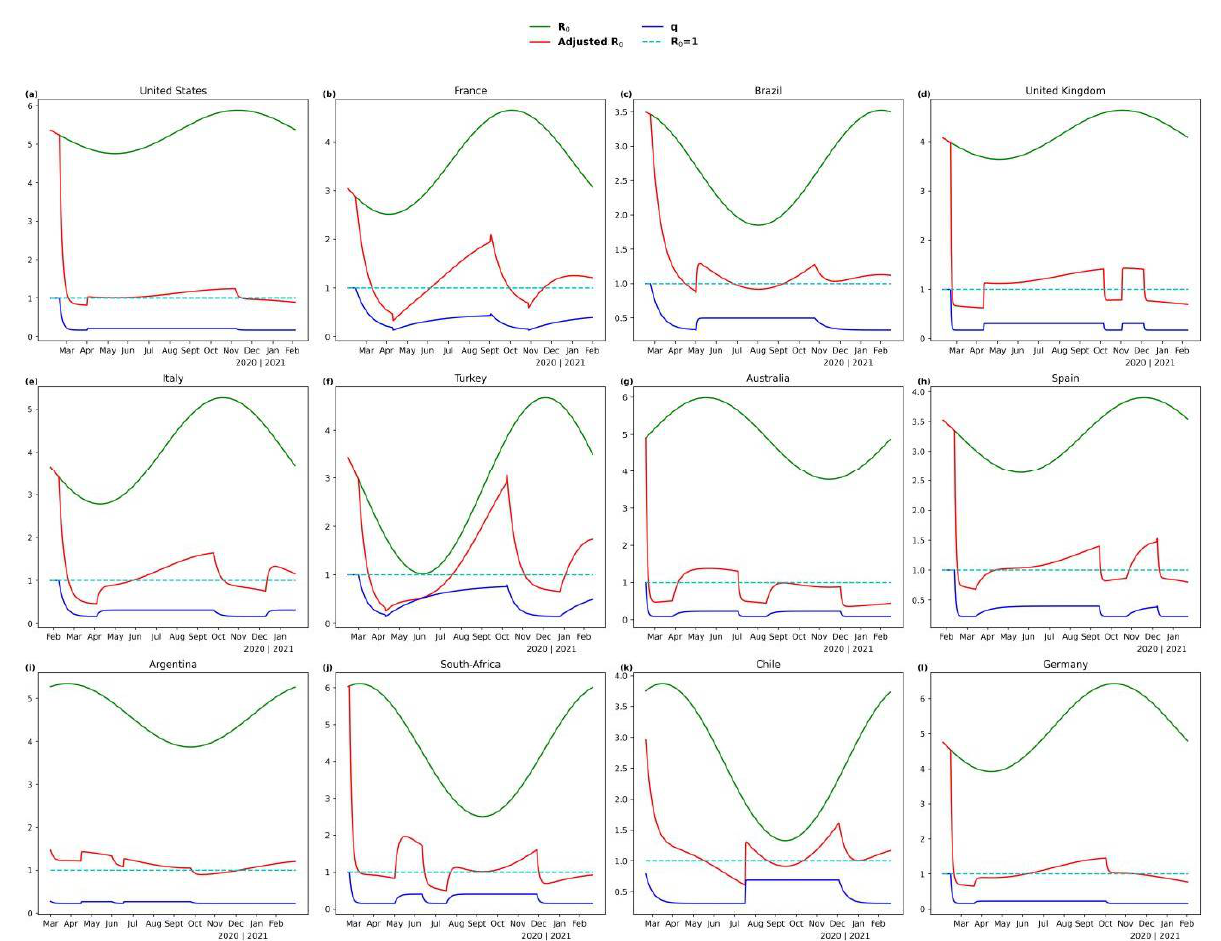
Figure 3. The curves of (cid:1844) (cid:2868) ((cid:1872)) , (cid:1844) (cid:2868)(cid:4593) ((cid:1872)) and q(t) of each selected country. ( a ) United States; ( b ) France; ( c ) Brazil; ( d ) United Kingdom; ( e ) Italy; ( f ) Turkey; ( g ) Germany; ( h ) Australia; ( i ) Spain; ( j ) Argentina; ( k ) South-Africa; ( l ) Chile.